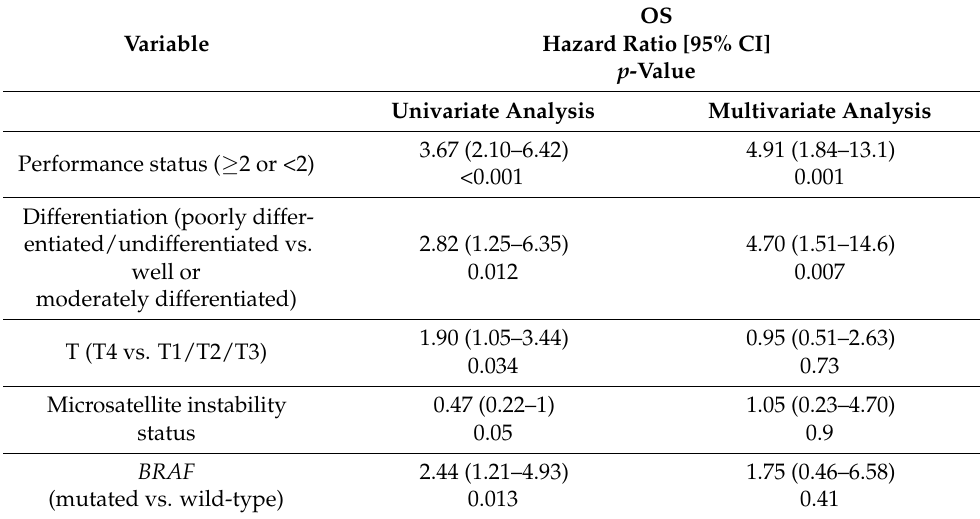
Table 3. Univariate and multivariate analysis on overall survival